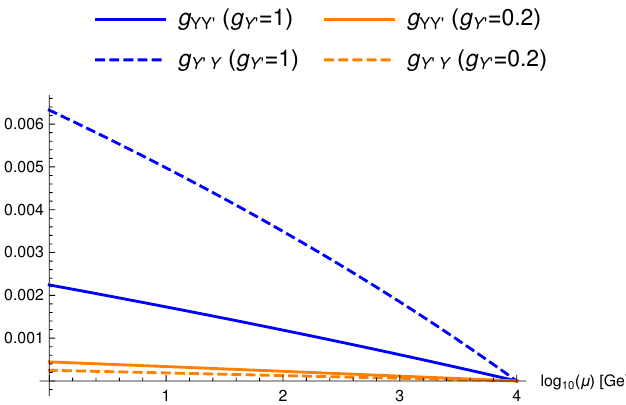
Figure 2: Running of the effective mixing between U ( 1 ) tation introduced in Equation 25 for Λ = 10 TeV. The g coupling of the mostly U ( 1 )